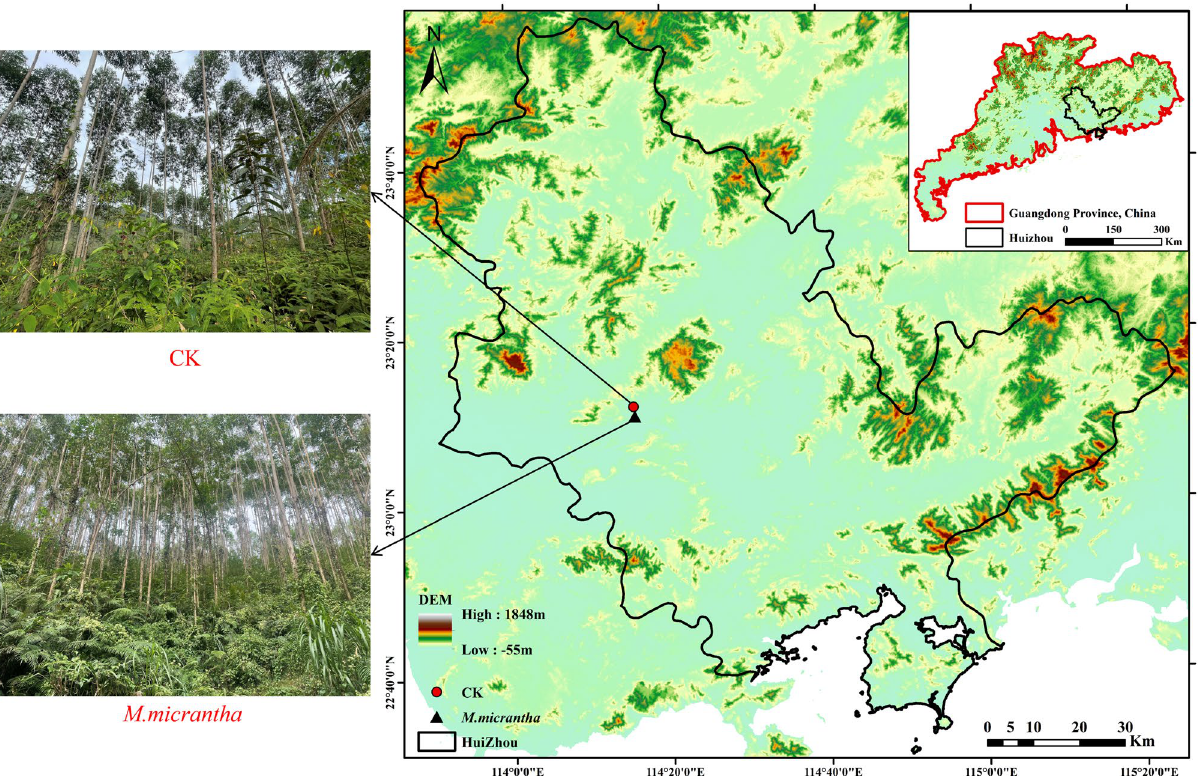
Figure 1.. Spatial distribution of sampling sites in Xiangtoushan National Nature Reserve, Guangdong province, China. The black solid triangle represents M. micrantha site while the red solid circle represents CK site. In addition, the depth of color represents the elevation in the DEM. And the map was generated with ArcGIS 10.2 (ESRI, Inc., Redlands, CA, USA, http:// www. esri. com/ softw are/ arcgis/ arcgis- for- deskt